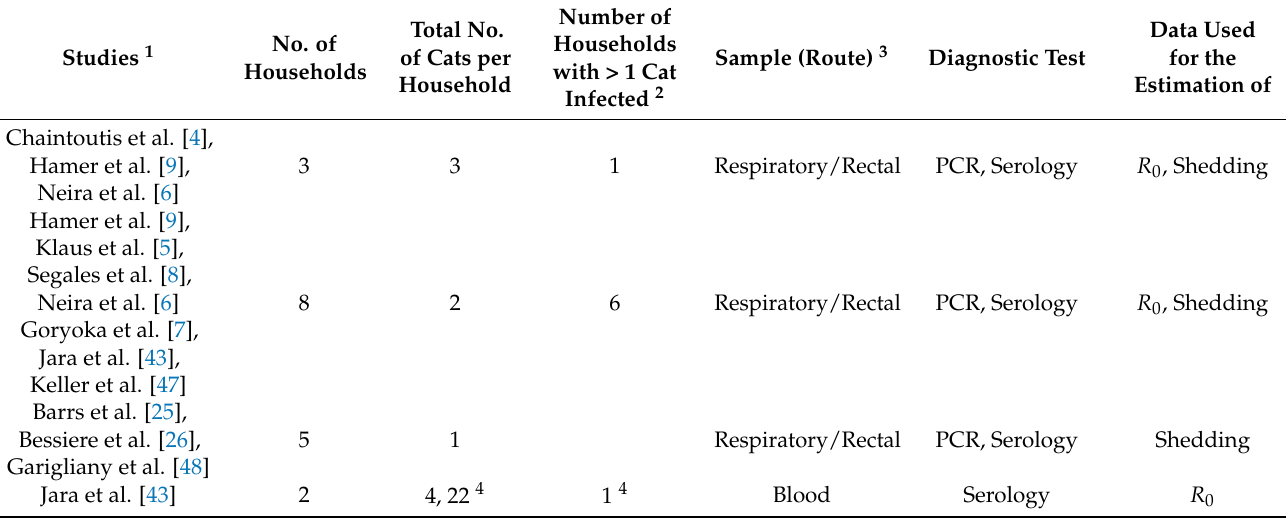
Table 2. Summary description of the households studies included for estimation of the shedding (infectious) period and the Reproductive Number